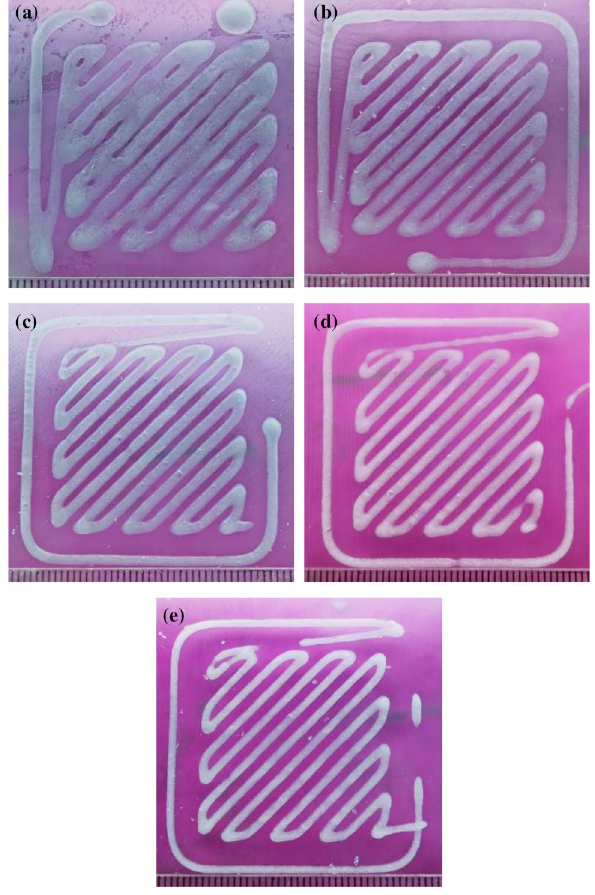
Fig. 4 Square spiral patterns printed by hydrocolloids with varying xanthan gum contents. a 1%; b 2%; c 3%; d 4%; e